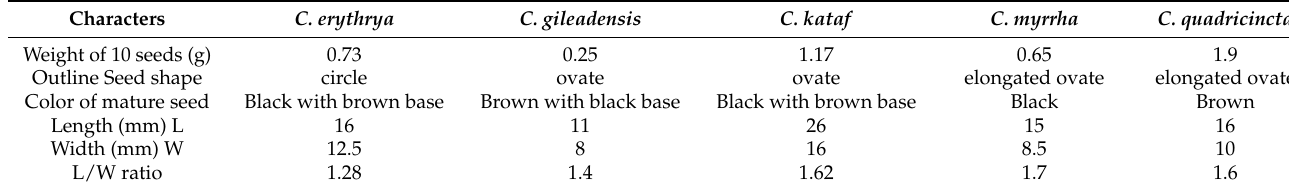
Table 6. Seed macro-morphological variations of Commiphora species using L.M.